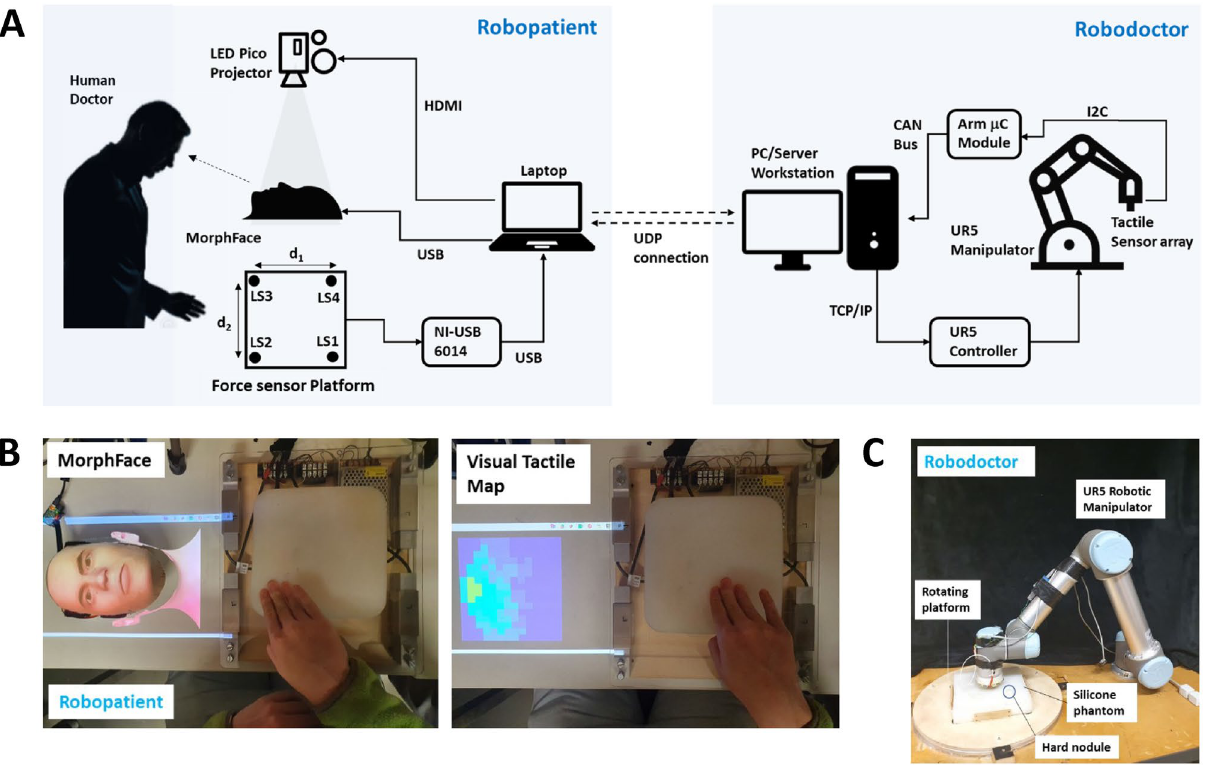
Figure 2. Overall system diagram and how the participants saw the two types of feedback during the experiment. (A) complete system diagram of the robopatient–robodoctor platform for remote palpation (B) Left shows how a participant sees the robopatient face during face mediated approach experiment. (B) Right shows How the visual tactile map would look like during the experiment. (C) The robodoctor site consists of a UR5 robotic manipulator, a rotating platform, and a silicone phantom with an embedded hard in the Fig. 3A. The pattern of the colored pixels informs about the size/shape of the nodule as well as where the hard nodule is pressed against the tactile sensor array (e.g., whether the nodule is pressed over the centre of the tactile sensor array or near the perimeter of the sensor array). This allows the user to vary the palpation posi- tions to approach towards the hard nodule. In the experiment, we asked participants to start palpating around the center of the phantom and use any exploration strategy to estimate the respective nodule position using two feedback methods. Each participant performed 20 trials with face mediated approach and 20 trials with visual tactile map as feedback with maximum trial duration set to 90 s (i.e., we instructed participants that they have 90 s to estimate the nodule otherwise the trials are considered as unsuccessful). We counterbalanced the order of the feedback method across participants to avoid any order effects. A snapshot of the robodoctor site is shown in Fig. 2C. We fabricated one silicone phantom with a hard nod- ule (a 3D printed ABS ball with a diameter of 15 mm) embedded and placed on a rotating platform under the robodoctor. We manually rotated and locked the platform in one of the four orientations before each trial to change the position of the hard nodule across the experiment. We randomized the orientation of the platform for each trial across the experiment. A video taken during a trial with face mediated approach and visual tactile map feedback is presented in Movie S1. Figure 4 shows how a participant explored and estimated the hard nodule positions during a trial with the face mediated approach (Fig. 4 Left) and a trial with the visual tactile map feedback (Fig. 4 Right). The partici- pant started palpation exploration from around the center of the phantom as instructed and was free to use any exploration strategy to find the hard nodule. Actual location of the hard nodule on respective trials are marked as crosses in the plot. Each filled scatter circle represents a palpation point and lines show the palpation path from start to end. In both trials, the participant estimated the position of the hard nodule within 90 s. Each palpation point is color-coded according to the trial completion percentage where lighter colors represents a higher per- centage of trial completions. Results from these two trials show that the participant localizing the hard nodule position more accurately (based on the distance between the actual nodule position and the estimated nodule position) with face mediated approach compared to visual tactile map approach. Figure 5A shows the estimated nodule positions across all participants during all successful trials for each feedback format (total number of successful trials for face mediated approach and tactile feedback method = 288 and 307, respectively). On each trial, we presented one hard nodule in the phantom placed under the robo- doctor-the location of this nodule is represented as a bold symbol in the scatter plots (see legend to bottom left). Therefore, each of bold symbols indicate the actual nodule positions during all successful trials. The estimated